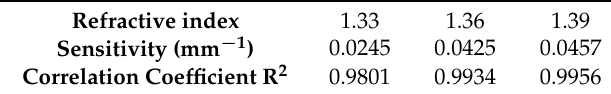
Figure 6. The sensor responses for testing liquids with refractive indices of 1.33, 1.36, and 1.39, respectively, where the V-groove pitch, depth, and angle of the sensor probe are 1 mm, 100 µ m, and 60 ◦ , respectively. Table 3. The results (unit: mm − 1 ) from Figure